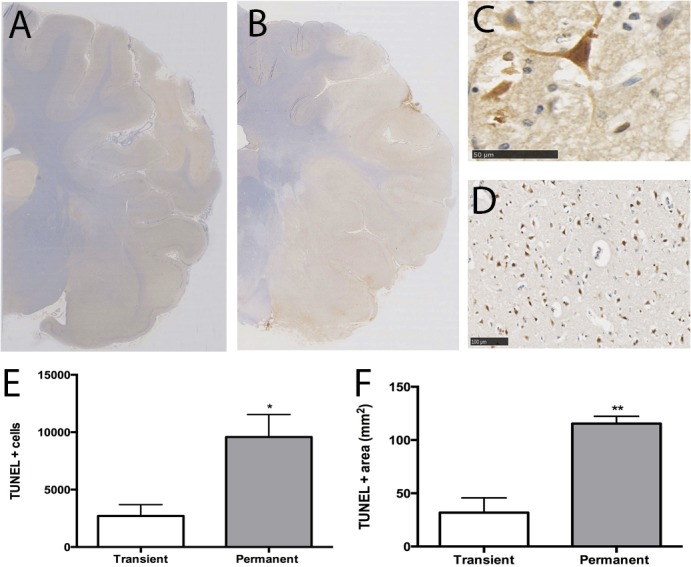
TUNEL staining.TUNEL immunoreactivity, indicative of cell death, was observed throughout the infarcted tissue. The region of TUNEL immunoreactivity was larger and more widespread following permanent (B) than transient MCAO (A). TUNEL positive cells (C) were observed throughout the infarcted tissue, typically seen in areas of tissue vacuolation and extensive cell injury (D). The number of TUNEL positive cells (E) and total area of TUNEL immunoreactivity (F) was significantly higher following permanent than transient MCAO. n = 3/gp.